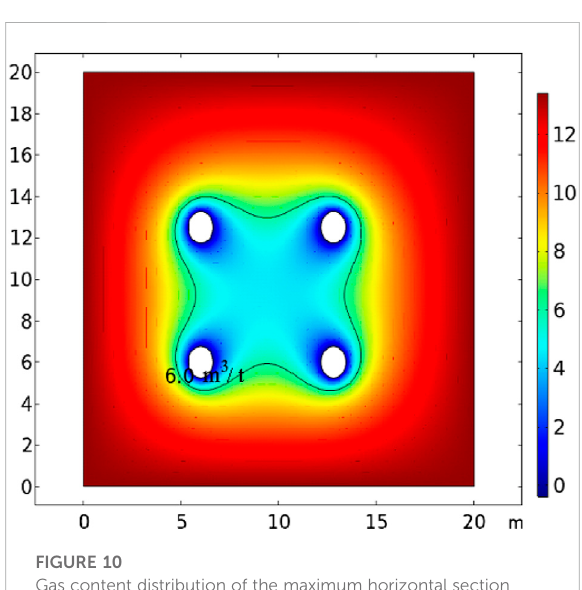
FIGURE 10 Gas content distribution of the maximum horizontal section of the equivalent ellipsoid